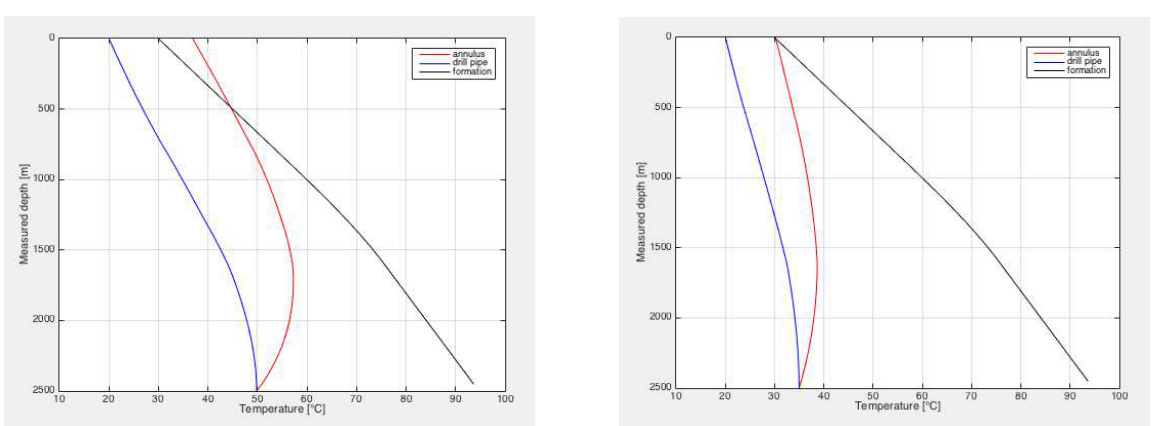
viscosity. To investigate the effect of flow rate on the temperature distribution, simulations have been per- formed using the base case with varying flow rates from 100 l/min to 2250 l/min. The results of flow rates at 500 l/min and 2000 l/min are given by Figures 2 and 3 respectively.